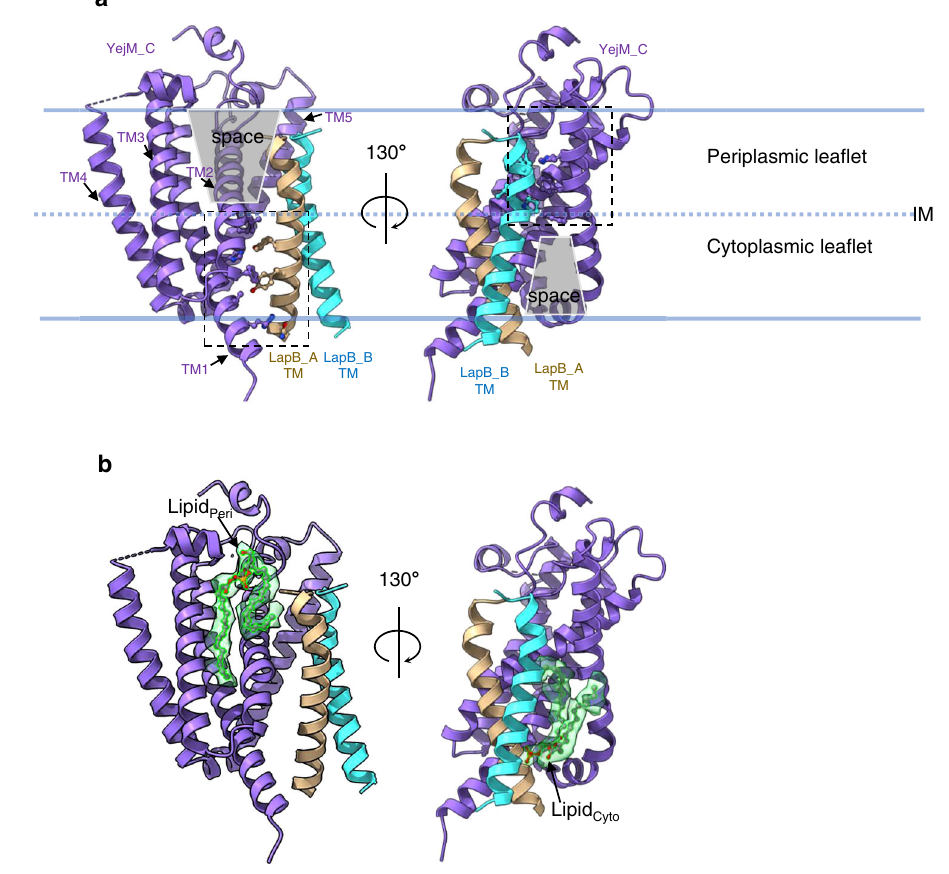
Fig. 3 | Lipid-mediated interactions between the YejM_C and the LapB dimer. a Interactions between the YejM_C and each LapB molecule are located in the differentlea fl etsoftheIM.Thethickbluelinesindicatetheboundariesoftheinner membrane (IM) and the dashed line indicates the interface of two lea fl ets. Dashed rectangles highlight protein/protein interactions in each lea fl et. Residues involved